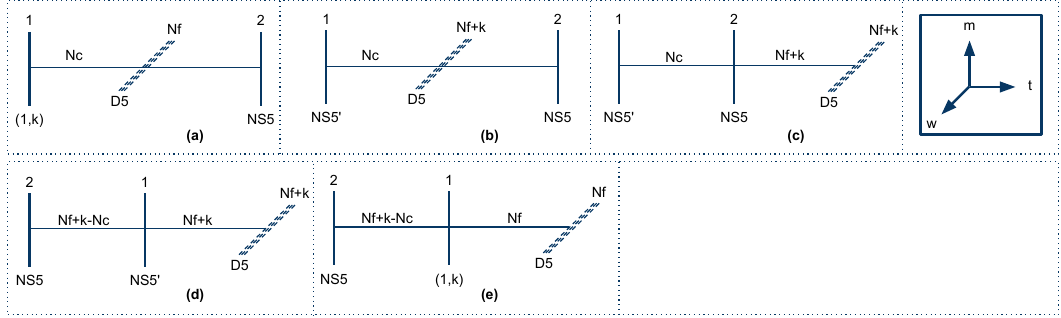
Figure 2 . Brane manipulations in type IIB string theory which yield a duality between Chern Si- mons theories. Panels (b) through (d) relate a pair of theories without CS terms. The deformations of the theory needed to go from (b) to (a) and from (d) to (e) are